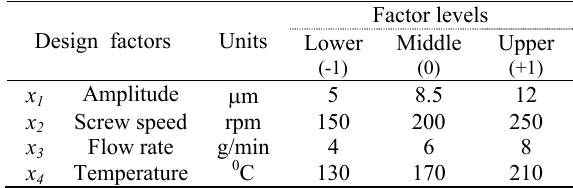
Table 8. Type of response and their specifications